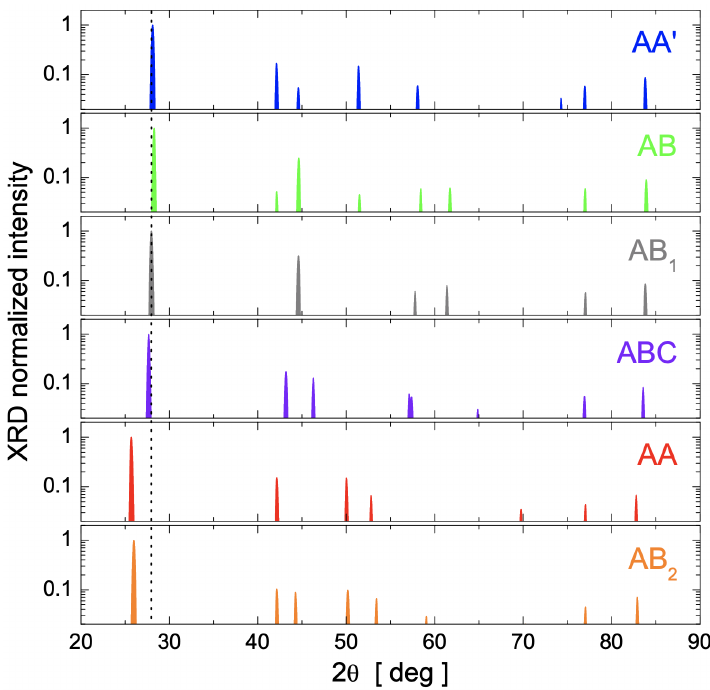
Figure 4. X-ray diffractograms computed for powders of sp 2 -bonded ordered BN stackings, based on the theoretical lattice parameters. The X-ray wavelength was taken equal to 1.541842 Å(Cu-K α